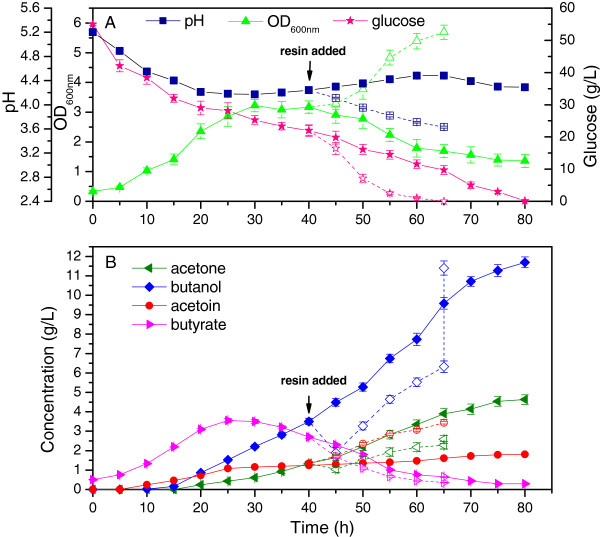
Kinetics of batch fermentation by planktonic culture. (A) pH, optical density (OD)600nm and glucose consumption; (B) product concentrations during the fermentation process. Initially, experiments were performed in six Duran bottles under the same condition. At 40 h, three of the bottles were supplemented with KA-I resin (final concentration 50 g/L) (open symbol and dashed line), with the other ones left as control (solid symbol and solid line). The mean value (± SD) was calculated from the results of parallel runs. The vertical dashed lines represent the equivalent concentrations adsorbed by the resin (determined by dividing the adsorbed amounts by the volume of the fermentation broth) at the end of the fermentation.